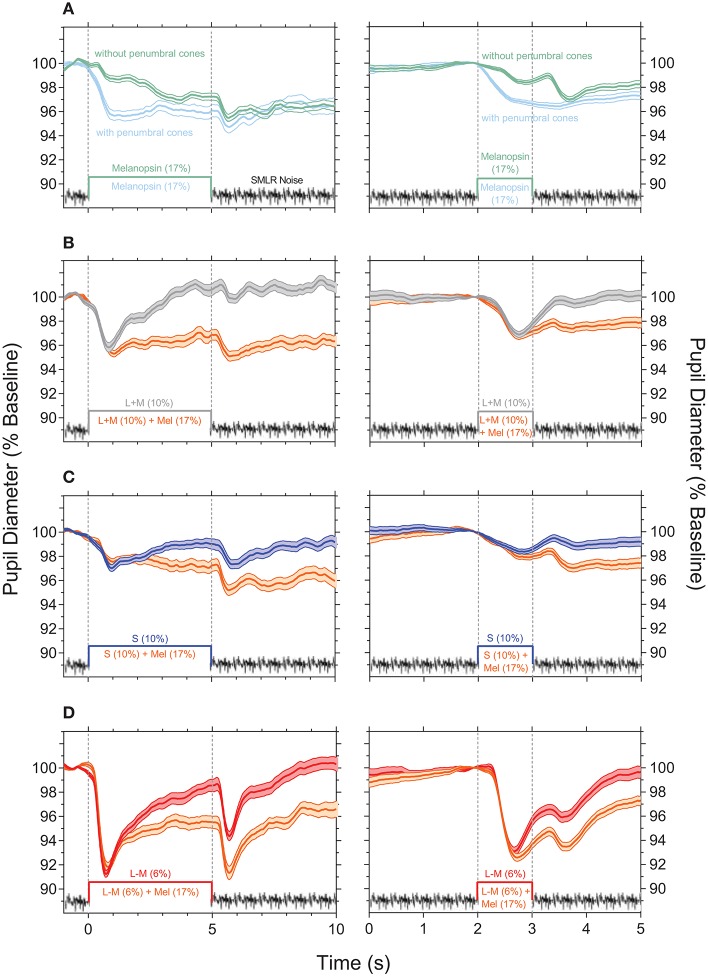
Light-adapted pupil responses measured under photoreceptor isolating conditions and with combined cone- and melanopsin-directed stimuli. (A) Melanopsin-directed pupil responses (17% Weber contrast in all measurements) measured with temporal white noise (without penumbral cones; green lines) and without temporal white noise (with penumbral cones; cyan lines). (B) +L+M cone luminance directed pupil responses (10% Weber contrast; grey lines) and the combined+ L+M cones and melanopsin responses (orange lines). (C) S-cone directed pupil responses (10% Weber contrast; blue lines) and the combined S-cone and melanopsin responses (orange lines). (D) +L–M directed pupil responses (6% Weber contrast; red lines) and the combined +L–M and melanopsin responses (orange lines). In all panels the data show the average ±95% confidence limits of 4 observers (~100 trials per observer). Dotted vertical lines indicate the onset and offset of the incremental pulses. Left column shows the PLR with 5,000 ms incremental pulses; right column shows the PLR with 1,000 ms incremental pulses. The average light-adapted baseline pupil diameter for all observers across all conditions was 4.43 mm ± 0.21 (mean ± SEM).